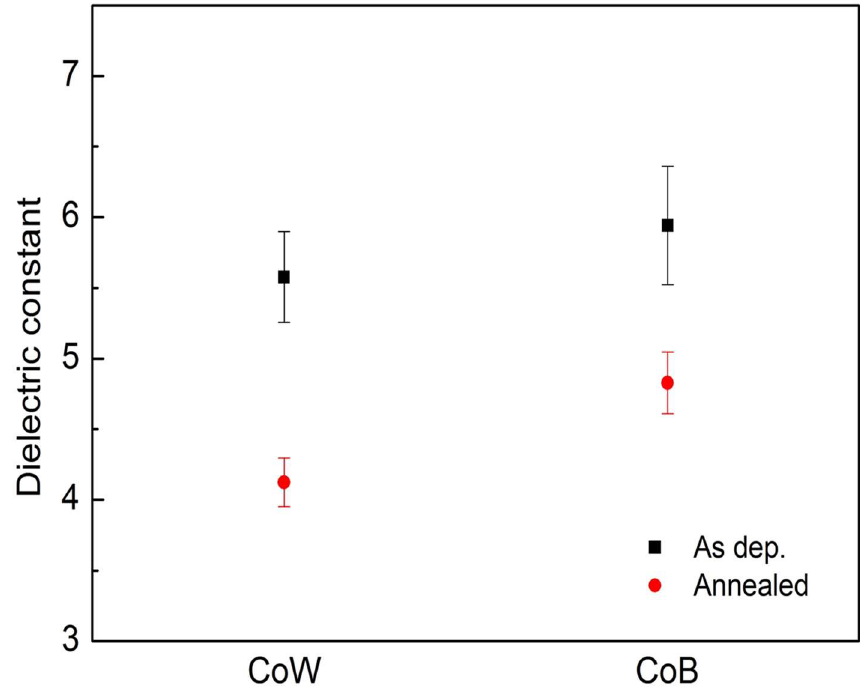
Figure 4. Dielectric constants of SiO 2 films in CoW-gate and CoB-gate MIS capacitors before and after annealing.